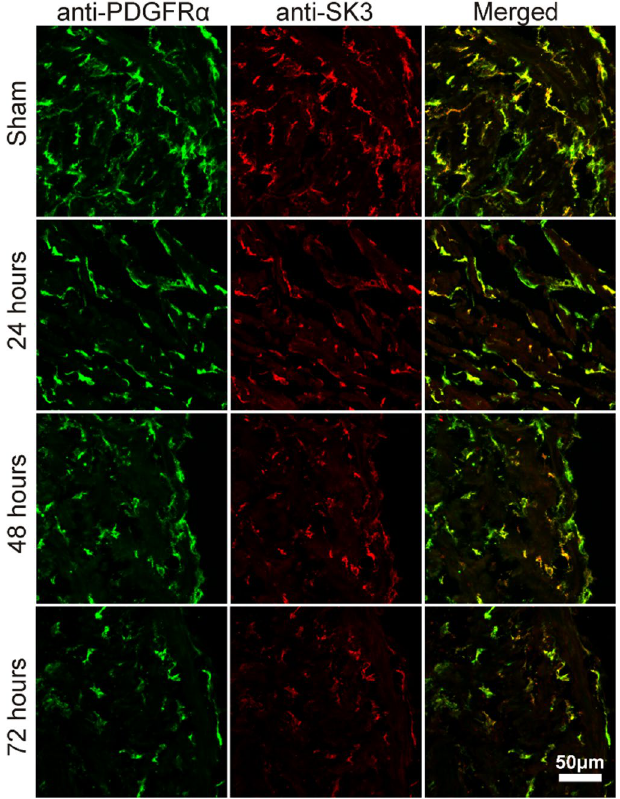
Figure 2. PDGFRα immunoreactivity of detrusor muscle layer in control and SCI. I mmunoreactivity of PDGFRα (green) and SK3 (red) in control (sham). SCI (24 h, 48 h and 72